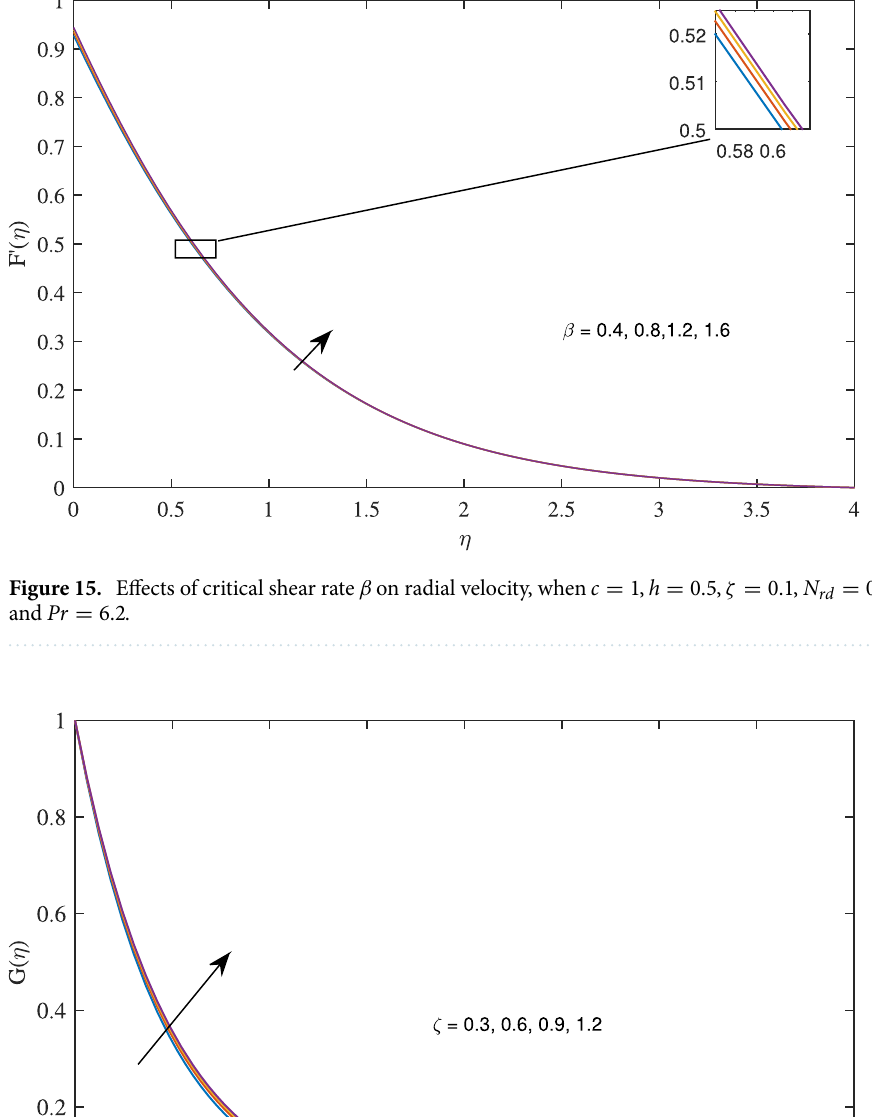
1 , h 0.5 , ζ 0.1 , N 0.2 , rd = = = =